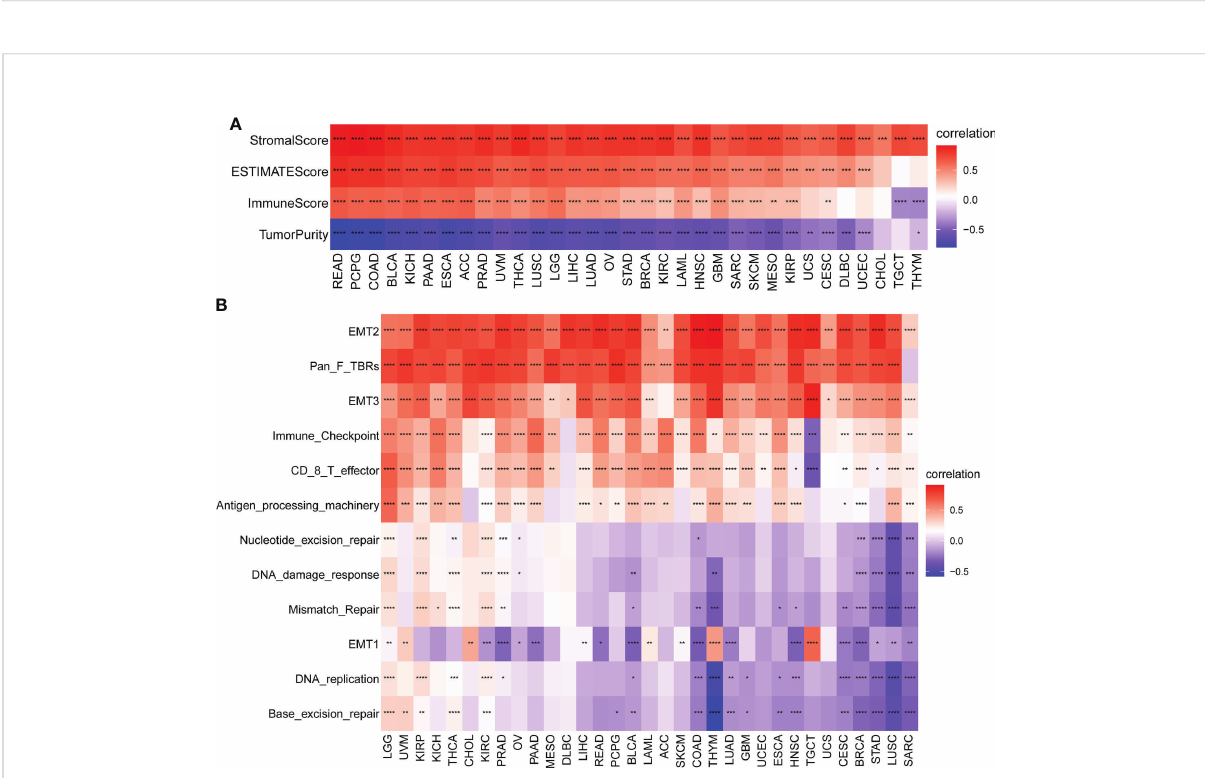
FIGURE 6 Tumor microenvironment (TME) analysis of AR score. (A) Heatmap represents the correlation between the AR score and immune score, stromal score, ESTIMATE score, and tumor purity score in pan-cancer. Red represents positive correlations and blue represent negative correlations. (B) Heatmap represents the correlation between the AR score and TME-related pathways. Red represents positive correlations and blue represent negative correlations. *P < 0.05, **P < 0.01, ***P < 0.001, ****P <